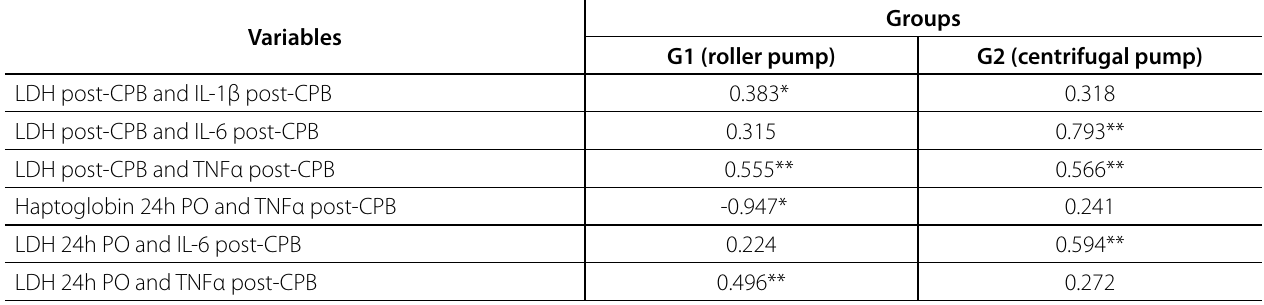
Table 5. Spearman coefficients of linear association between markers of hemolysis and inflammation, stratified by group.